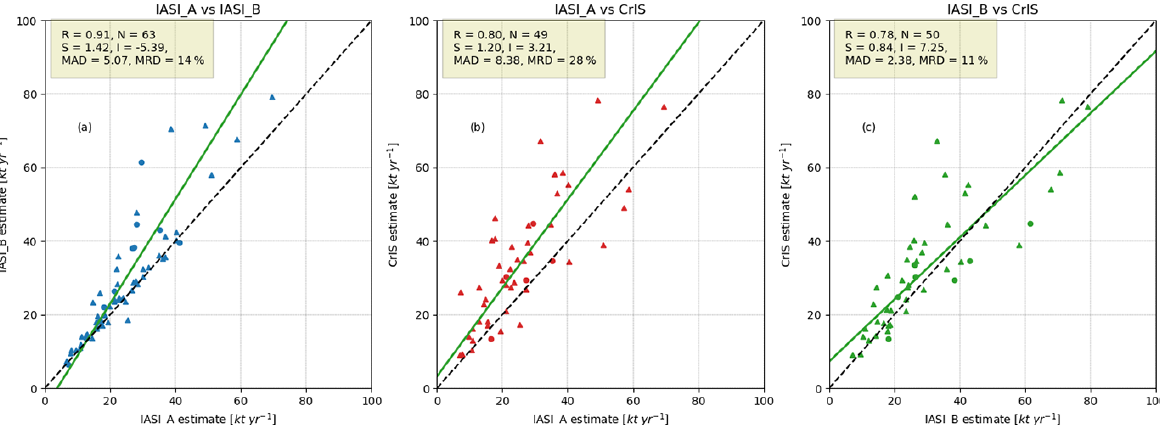
Figure 7. IASI-A vs. IASI-B and IASI-A vs. CrIS for locations with r > 0 . 5 with a fixed σ of 15km and lifetime of 2.5h. 2013–2017. R indicates the correlation between the sets, N the number of locations, S and I the resulting slope and intercept of the regression (RMA) and the mean absolute difference ( y − x ) and the mean relative difference ( y − x/( 0 . 5 y + 0 . 5 x) ) (MAD and MRD). Triangles indicate locations with agricultural emissions equal to and above the sum of all other classes in the HTAPv2 inventory.